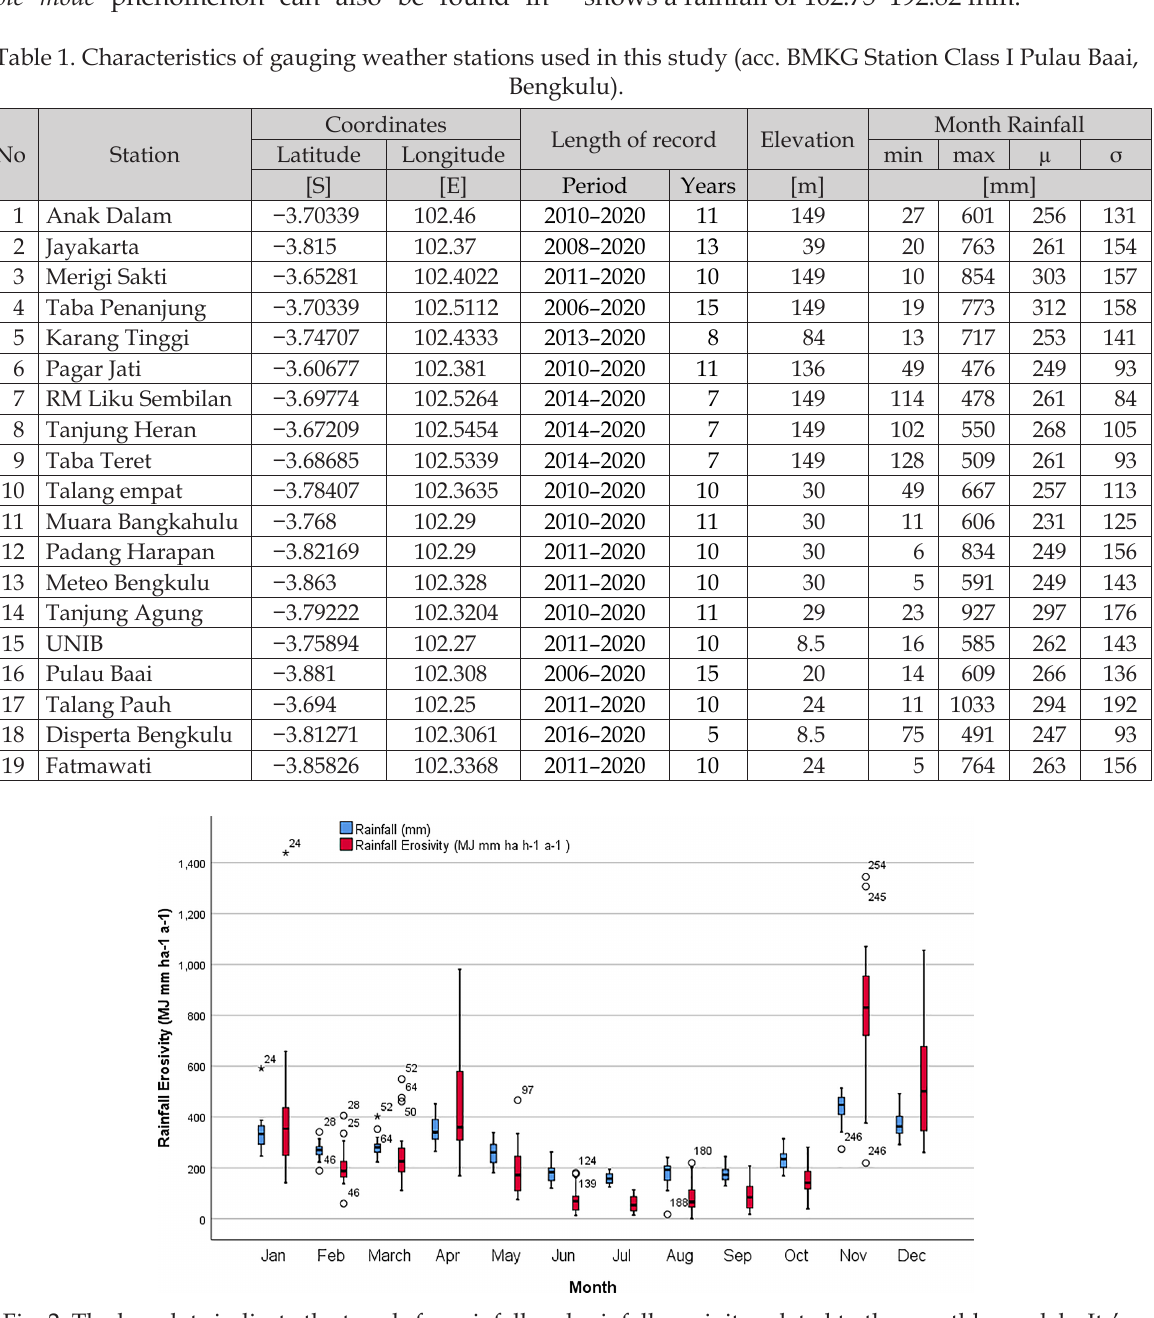
Fig. 2. The boxplots indicate the trends for rainfall and rainfall erosivity related to the monthly models. Its’s displayed in figure rainfall (blue), rainfall erosivity (red) in the Air Bengkulu